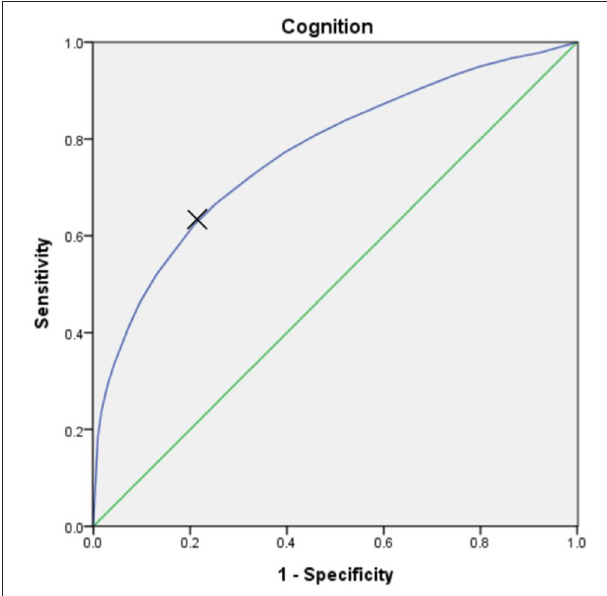
FIGURE 2 | The Receiver Operating Characteristic (ROC) curve, which was utilized to predict the cognitive disability (score of WHODAS 2.0 domain 1) in PwP by ambulatory status. At the cut-off value of 58, the area under the curve was 0.77, with sensitivity and specificity of 62% and 79%, respectively.